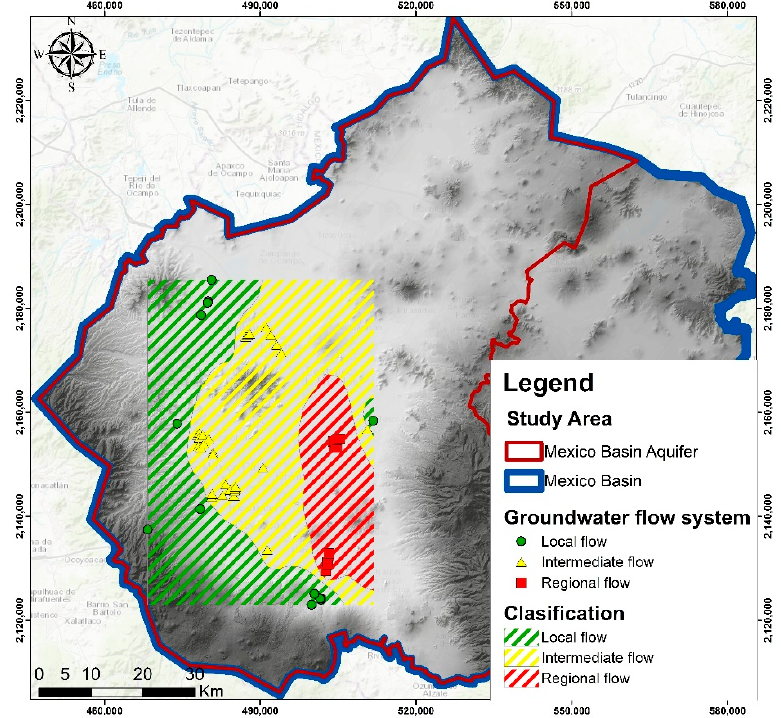
Figure 16. Plan view of the conceptual model of the MBA. Figure 15. Plan view of the conceptual model of the